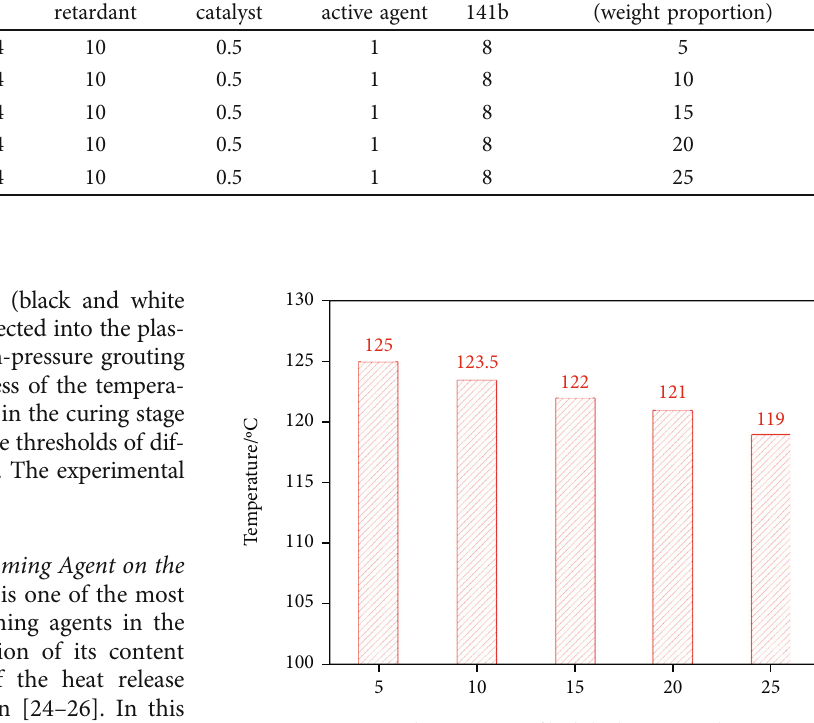
Figure 7: In fl uence of the weight proportion of high-boiling point solvent on the curing temperature